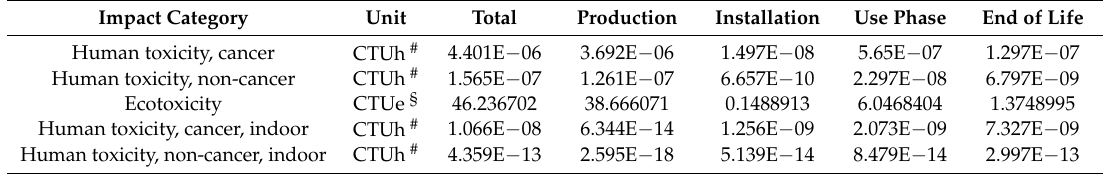
Figure 5. Environmental profile of 1 m 2 of nanoTiO 2 self-cleaning coated float glass (characterization results). Table 5. Characterized LCIA results of 1 m 2 of nanoTiO 2 self ‐ cleaning coated float glass.